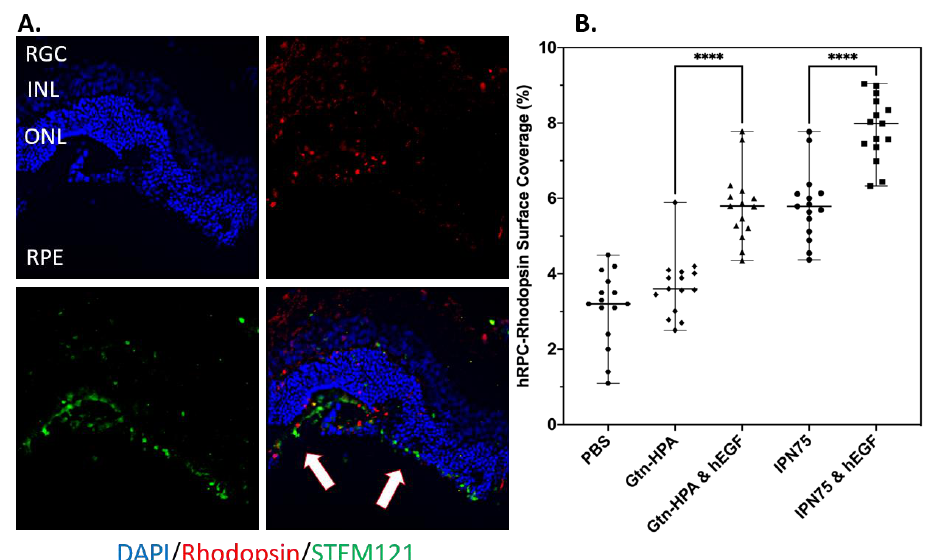
Figure 11. hRPCs survival, engraftment, and rod expression post-transplantation. ( A ) Immunohistochemistry for Gtn-HPA with hEGF group, stained with STEM121 (green), rhodopsin (red) and DAPI (blue). Scale bar: 200 µm. ( B ) Statistical analysis, using one-way ANOVA, followed by Pearson’s test, of the percentage of cell (expressing rhodopsin) surface coverage in injected groups. **** p < 0.0001.